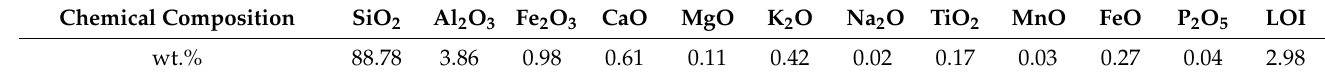
Table 1. The test result of main chemical composition of ATCA (%). Chemical